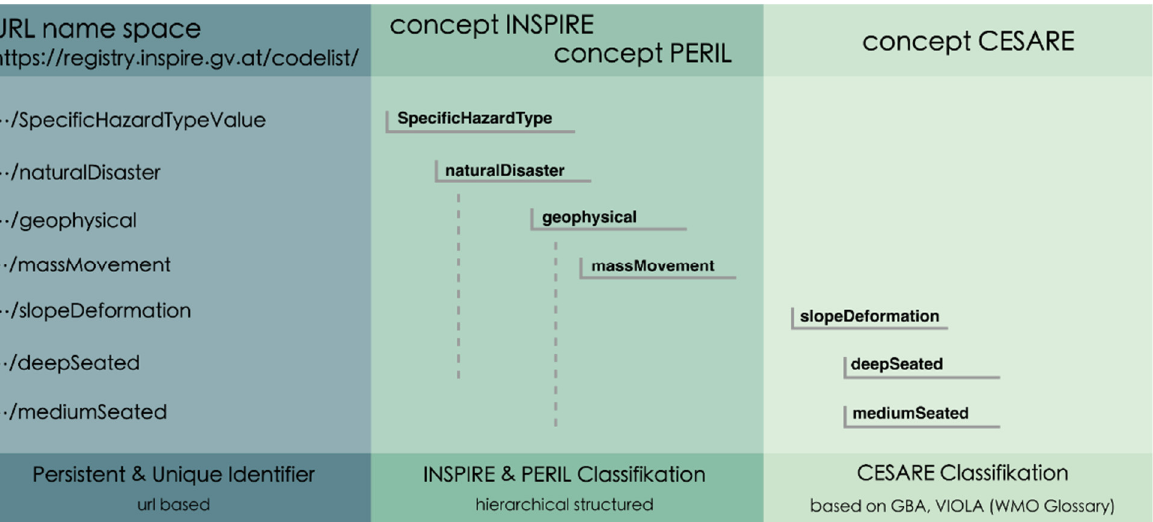
Figure 4. Example of controlled